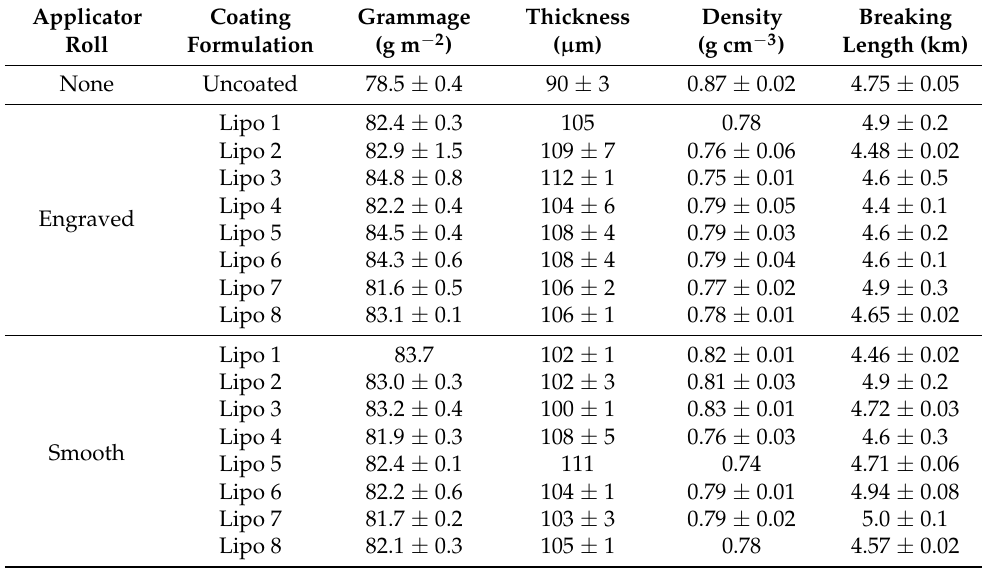
Table 4. Key properties of the sheets coated with lipophobic formulations. The amplitude of the intervals equals twice the standard deviation.